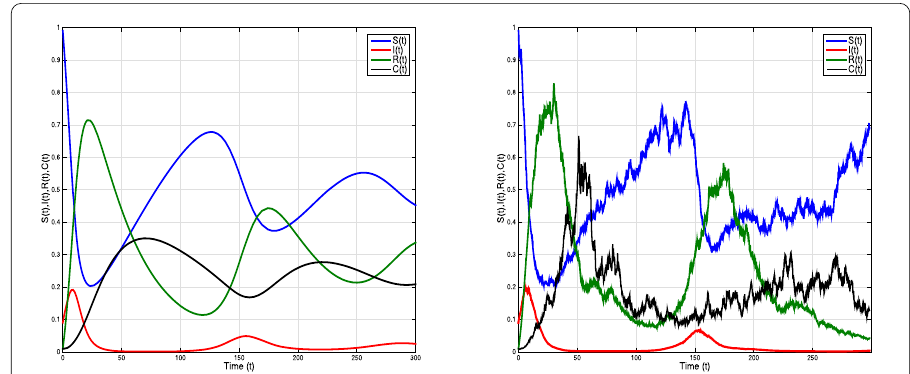
Figure 5 Simulations of stochastic model (2) (right) and the corresponding deterministic model (1) (left) when R s 0 = 0.38 < 1, with η = 0.0005, ξ = 0.6, β = 0.01, σ = 0.12, α = 0.3, γ = 0.02; τ = 2.5 and white noises ν